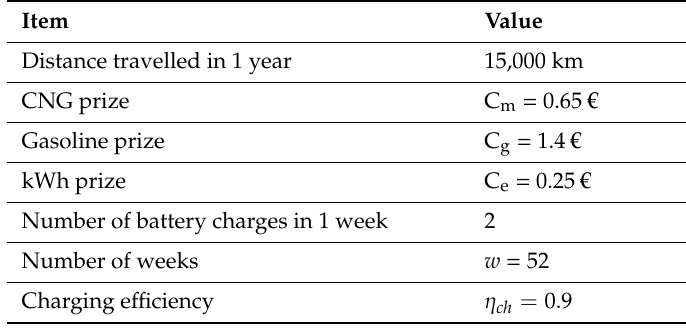
Table 34. Calculation parameters for operating